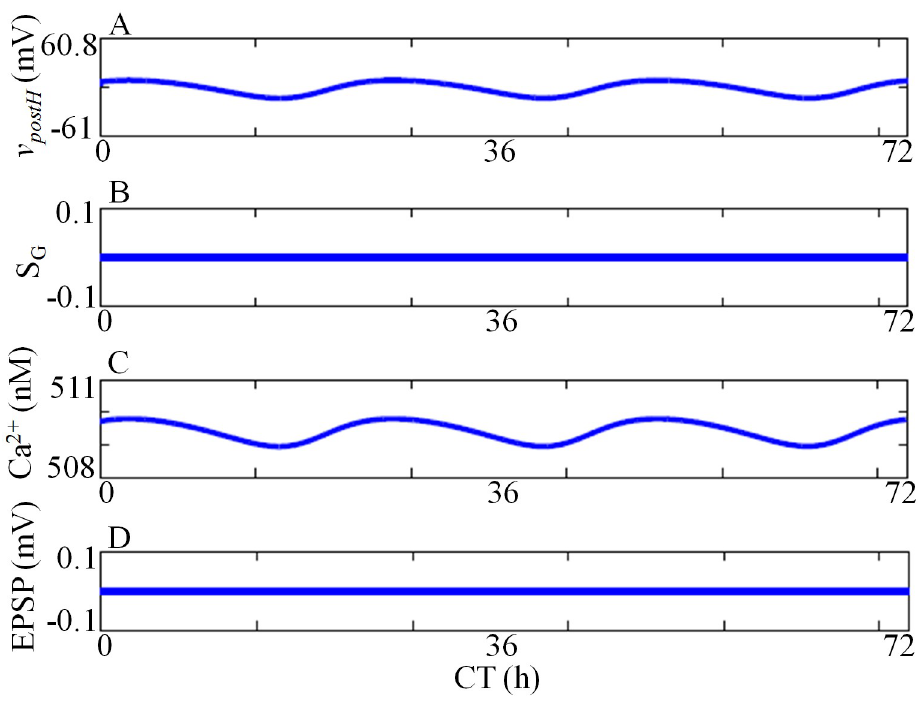
Fig 6. Circadian variation of SCN-hippocampus model variables without any pre-post activity. v postH and calcium concentrations shows circadian variation (A, C), and the corresponding time series of S